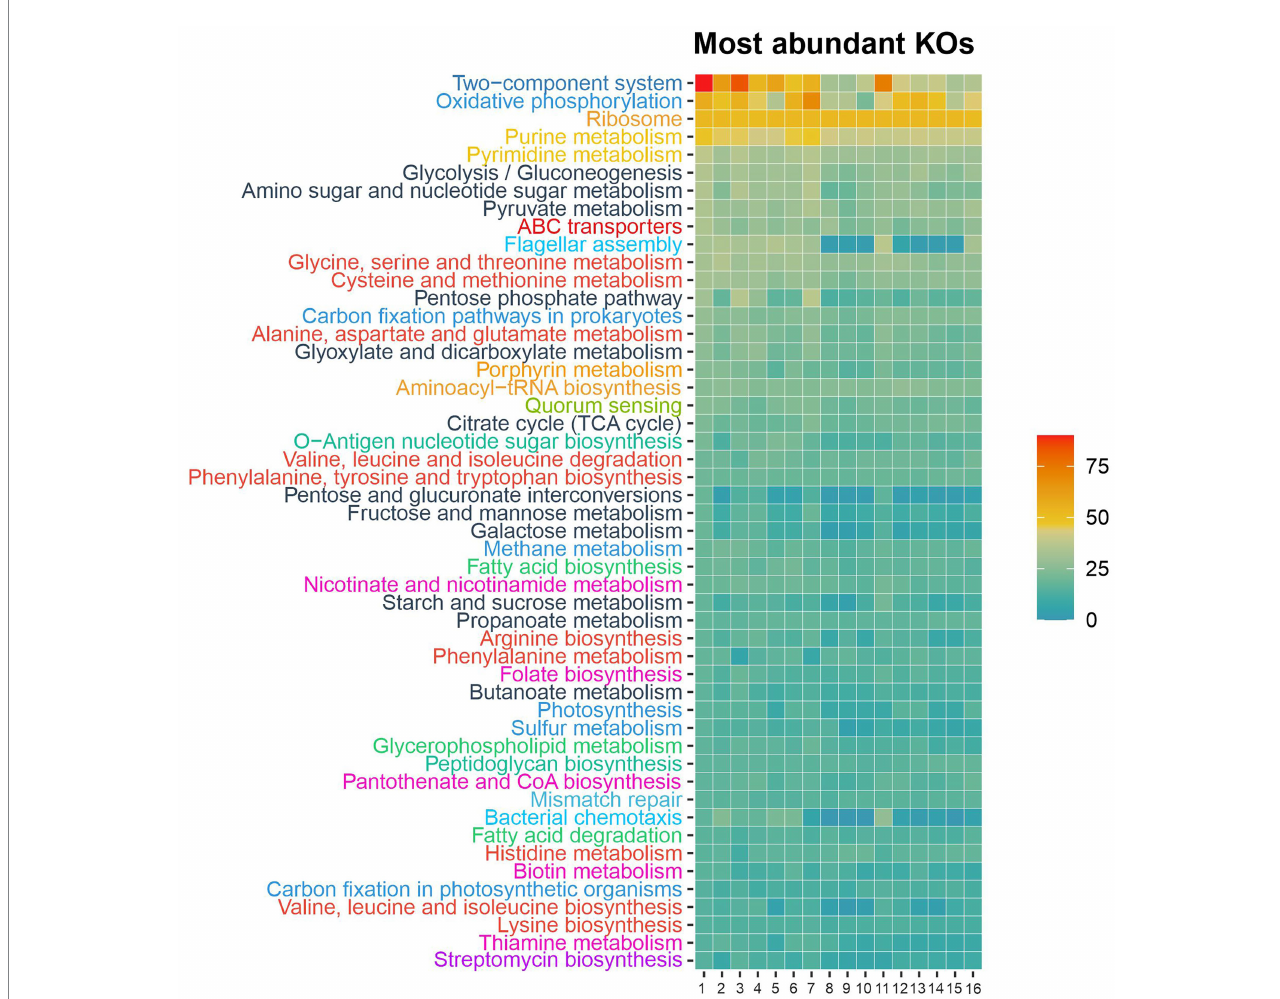
FIGURE 7 KO numbers grouped by KEGG categories annotated for the representative genomes of the family Balneolaceae . KEGG pathways are sorted according to their abundance in the strain 1BSP15-2V2 T and only the 50 most abundant are displayed. The most prominent pathways detected in those genomes belonged the following KEGG global categories: signal transduction (dark blue), energy metabolism (blue), translation (orange), nucleotide metabolism (yellow), carbohydrate metabolism (black), membrane transport (dark red), cell motility (light blue), amino acid metabolism (light red), cellular community (light green), glycan biosynthesis and metabolism (dark green), lipid metabolism (green), metabolism of cofactors and vitamins (pink), and biosynthesis of other secondary metabolites (purple). 1. Strain 1BSP15-2V2 T ; 2. Aliifodinibius halophilus 2W32 T ; 3. Aliifodinibius roseus DSM 21986 T ; 4. Aliifodinibius salicampi KACC 19060 T ; 5. “ Aliifodinibius salipaludis ” WN023 T ; 6. Aliifodinibius saliphilus ECH52 T ; 7. Aliifodinibius sediminis DSM 21194 T ; 8. Fodinibius salinus DSM 21935 T ; 9. Balneola vulgaris DSM 17893 T ; 10. Gracilimonas amylolytica LA399 T ; 11. Gracilimonas mengyeensis DSM 21985 T ; 12. Gracilimonas tropica DSM 19535 T ; 13. Halalkalibaculum roseum YR4-1 T ; 14. Rhodohalobacter barkolensis 15182 T ; 15. Rhodohalobacter halophilus JZ3C29 T ; 16. Rhodohalobacter mucosus 8A47 T